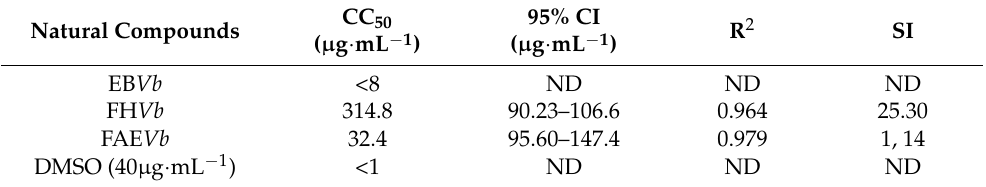
Table 5. Cytotoxic evaluation of crude extract and fractions from leaves of Vernonanthura brasiliana (L.) H. Rob, after 48 h of treatment in RAW 264.7 cells. Natural